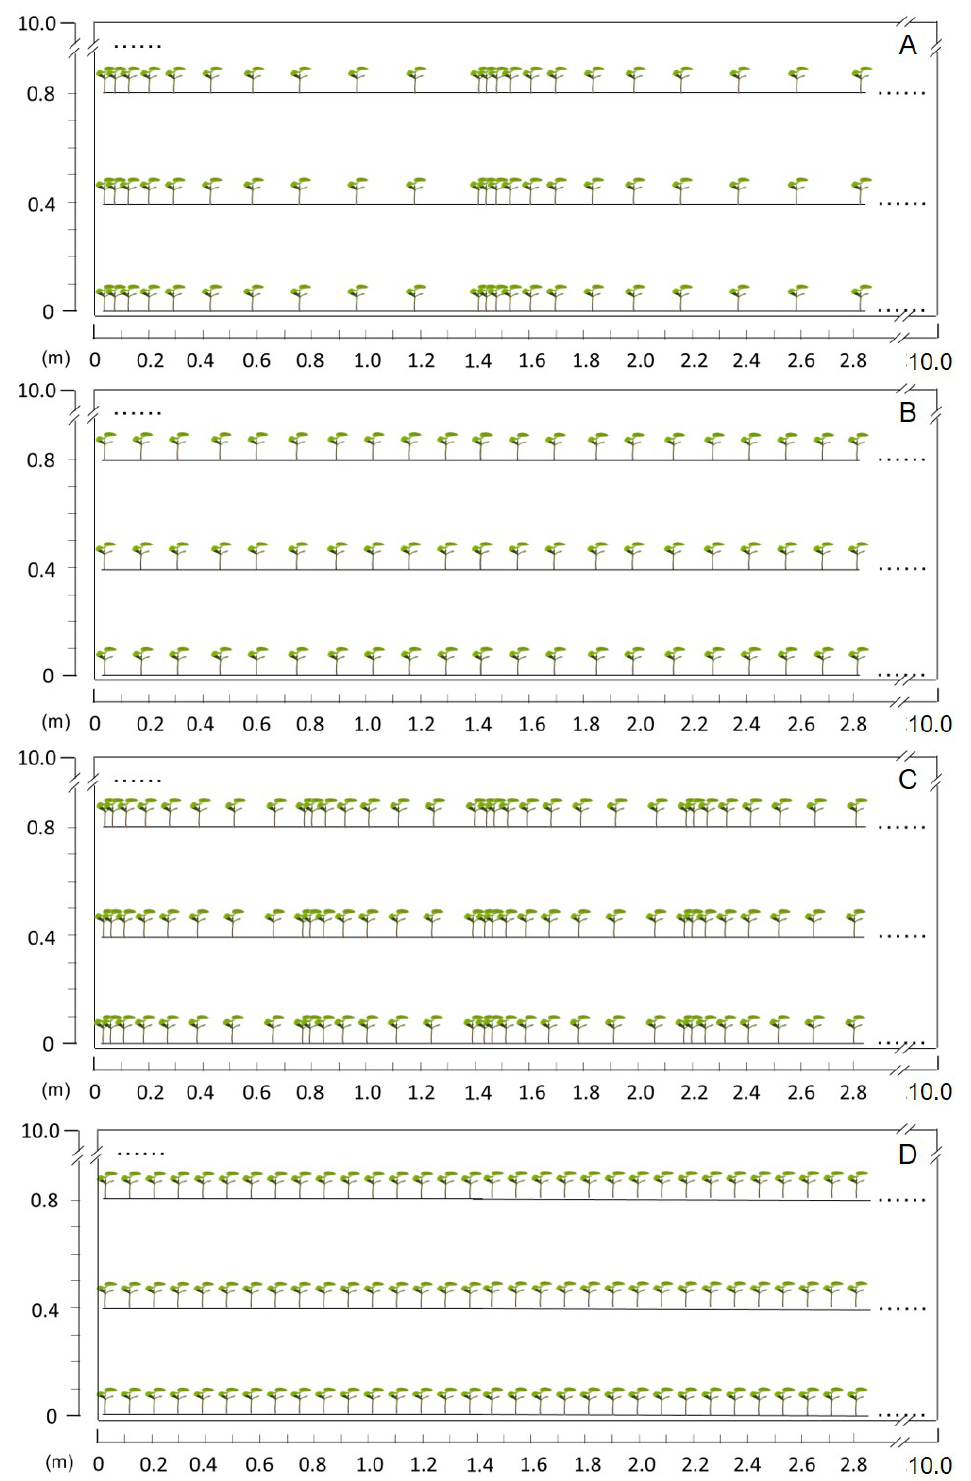
Figure 2. Soybean plant distribution patterns. ( A , B ) Non-uniform and uniform styles, respectively, under normal planting density (1.8 × 10 5 plants ha − 1 ). ( C , D ) Non-uniform and uniform styles, respectively, under high planting density (2.7 × 10 5 plants ha − 1